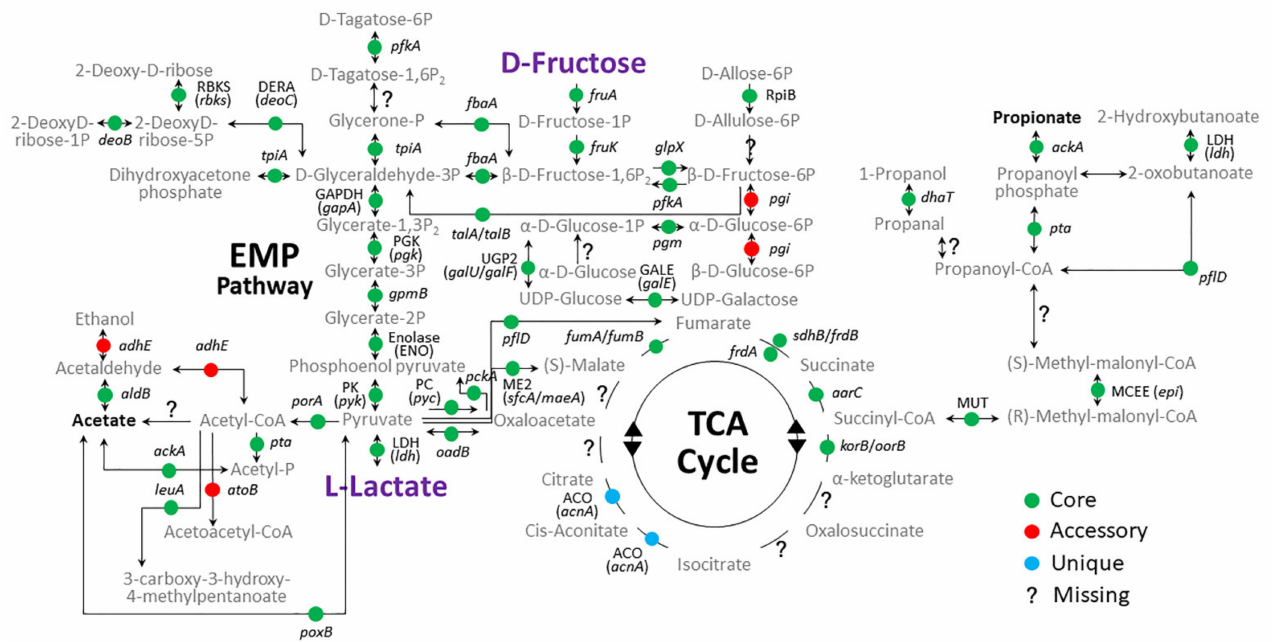
Figure 5. Incomplete pathway map integrated five KEGG pathways related to carbohydrate metabolism in oral Veillonella . Five KEGG pathways, 00010 Glycolysis/Gluconeogenesis, 00020 Citrate cycle (TCA cycle), 00051 Fructose and mannose metabolism, 00620 Pyruvate metabolism and 00640 Propanoate metabolism were partially integrated based on the mapping of the core, accessory and unique genes related to carbohydrate metabolism. This pathway is shown with intermediate metabolites and genes that are represented as core genes (green circles), accessory genes (red circles) and unique genes (light blue circles). Question marks in this pathway means the missing enzymes or genes that were not identified in this